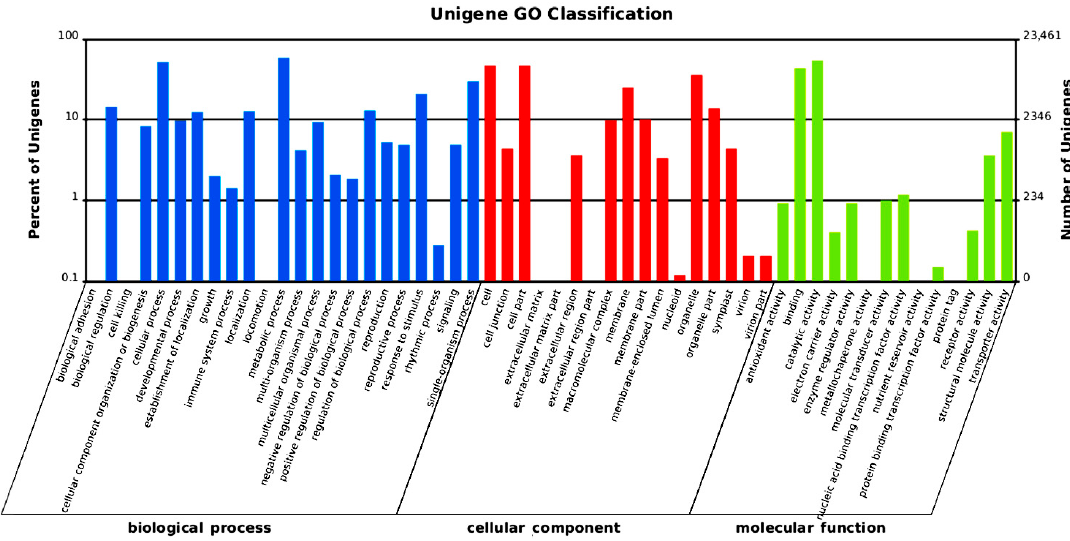
Figure 4. GO functional distribution of sequences. Biological process (blue); cellular component (red); and molecular function (green).